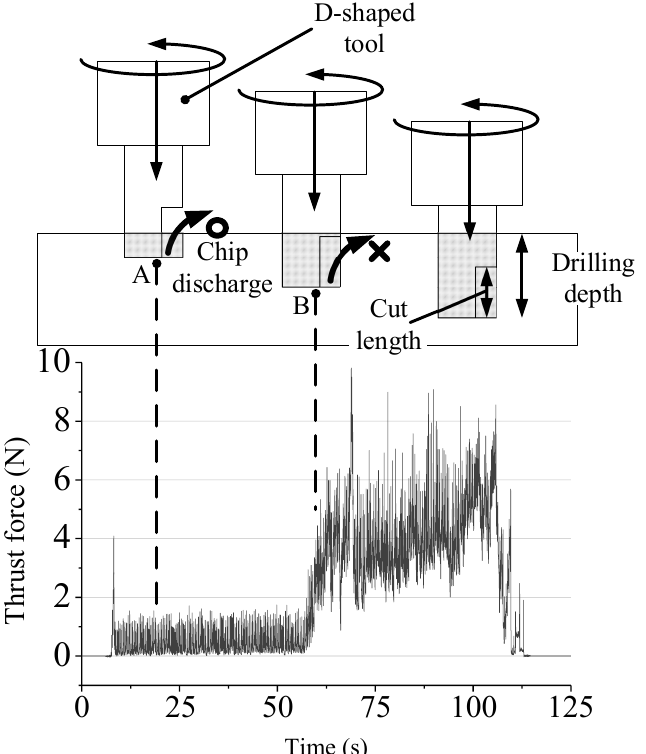
Figure 5. Thrust force and tool position during drilling (drilling conditions: axial feedrate 5 µ m/s; rotational speed of 50,000